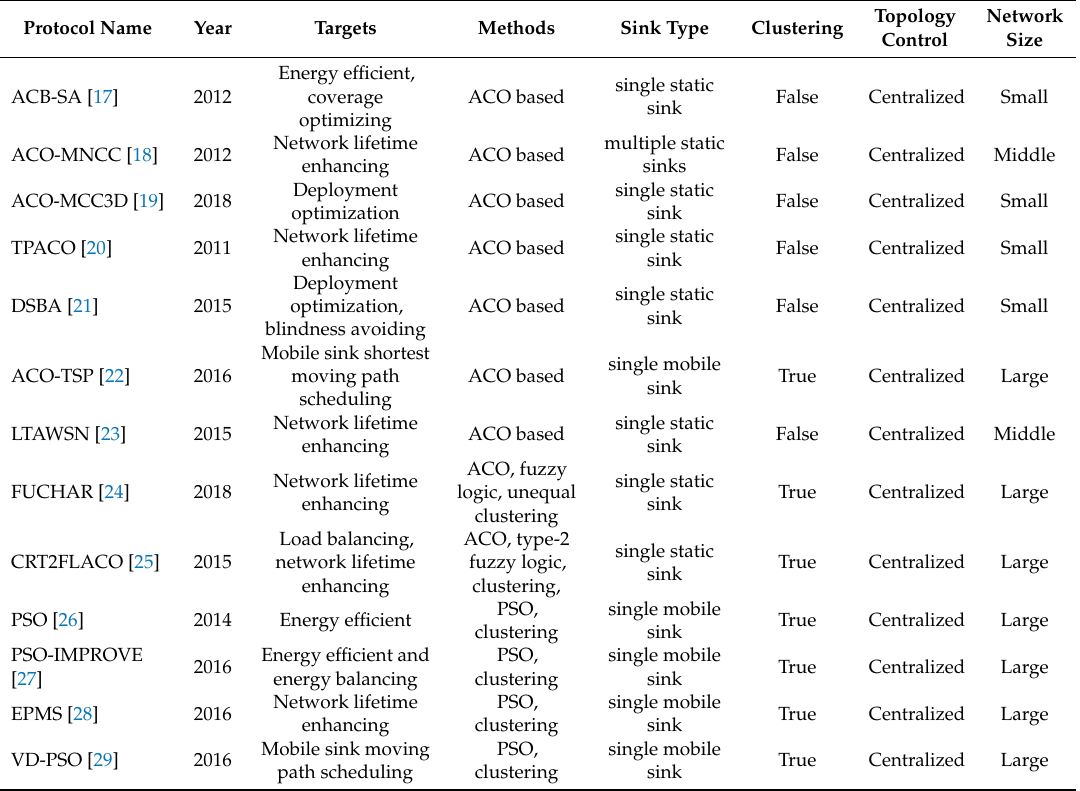
Table 1. Routing protocols which adopt ant colony optimization (ACO) and particle swarm optimization (PSO)